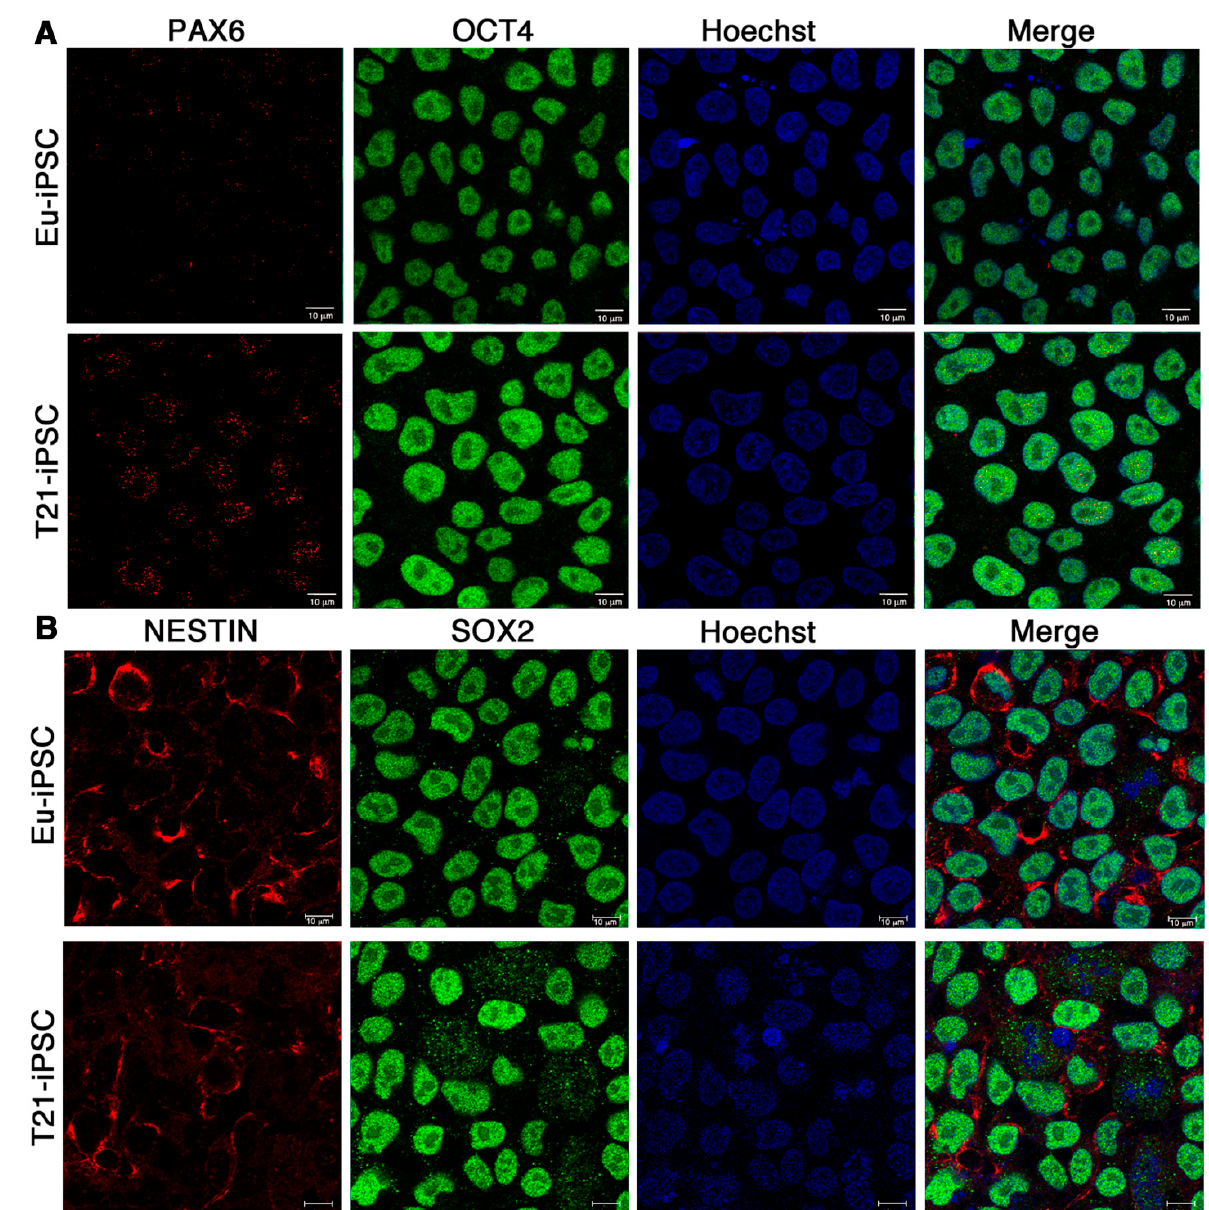
Figure 3. Immunofluorescence detection of stemness and differentiation markers in iPSCs. Expression of OCT4, PAX6, SOX2, and NESTIN was assessed by immunofluorescence and confocal microscopy in both Eu-iPSC and T21-iPSC clones. T21-iPSC images are representative of the two trisomic clones. ( A ) Representative images show that both cell types are negative when stained with the PAX6 antibody (red) and positive with the anti-OCT4 antibody (green). The anti-OCT4 antibody stains the nucleoplasm with the exclusion of nucleoli. ( B ) Both cell types show a low level of signal, mostly in the perinuclear area, when stained with the NESTIN antibody (red). The cell nuclei are positive when cells are stained with the SOX2 antibody (green). Nuclei are also stained with Hoechst (blue). Bar = 10 µ